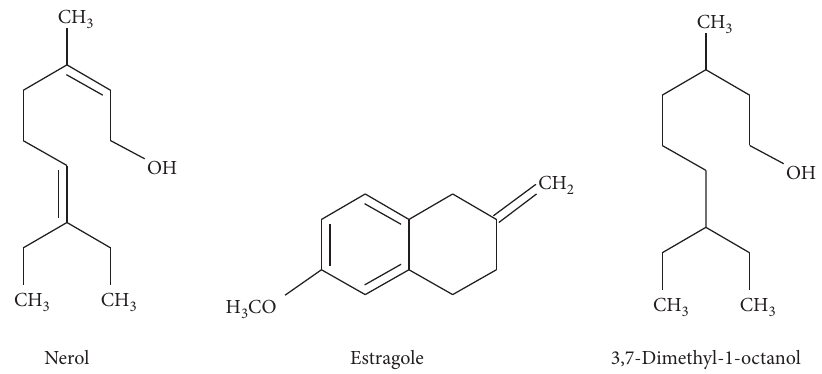
Figure 1: Te chemical structure of (a) nerol; (b) estragole, (c)